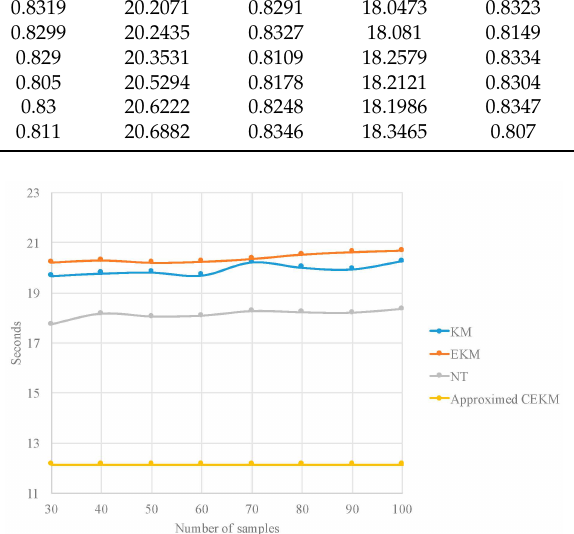
Table 17. Advantages and Disadvantages of the Approximate CEKM method.